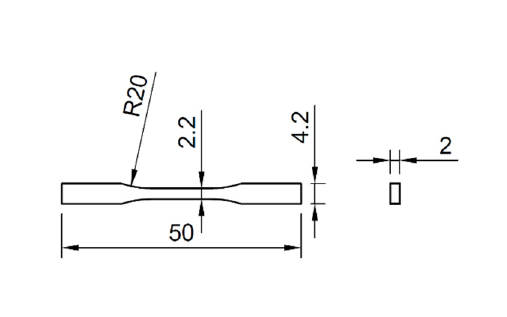
( e ) Figure 3. Sintering directions of cubes and their illustrations: ( a ) on xy surface; ( b ) on xz surface; ( c ) on yz surface; ( d ) on an edge; ( e ) on a point.